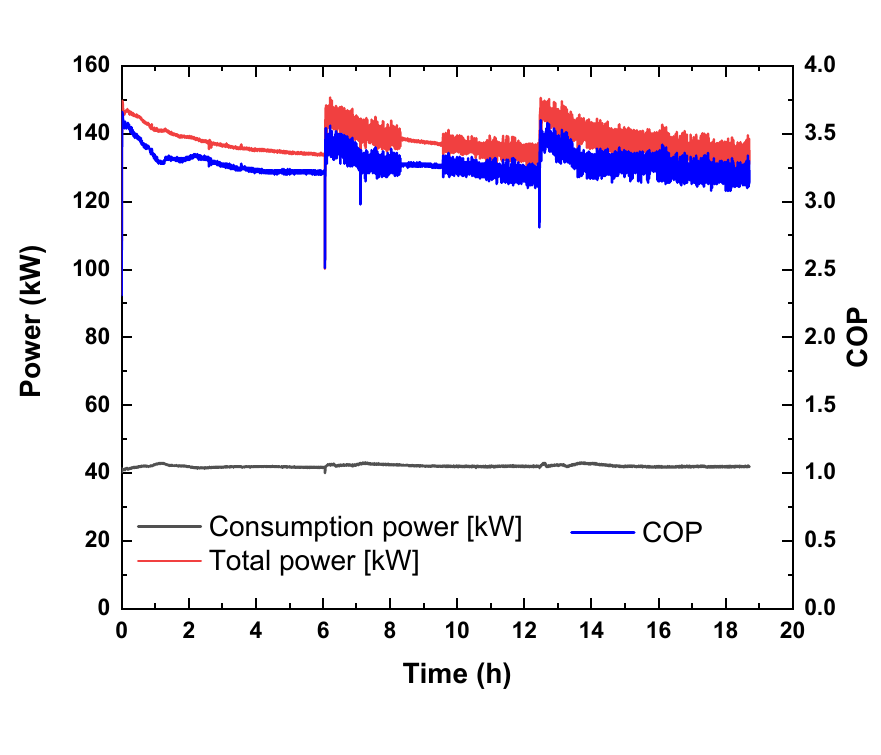
Figure 6. COP characteristics of the SCW and BW cross-mixing ground heat exchanger system during cooling operation. heating